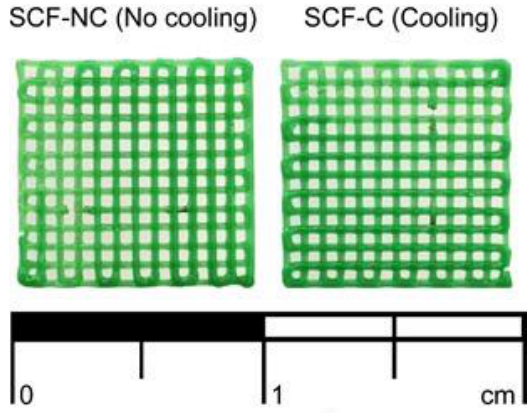
Figure 2. Scaffolds without printed and with the use of cooling stage (SCF-NC (no cooling) and SCF-C (cooling) specimens, respectively).